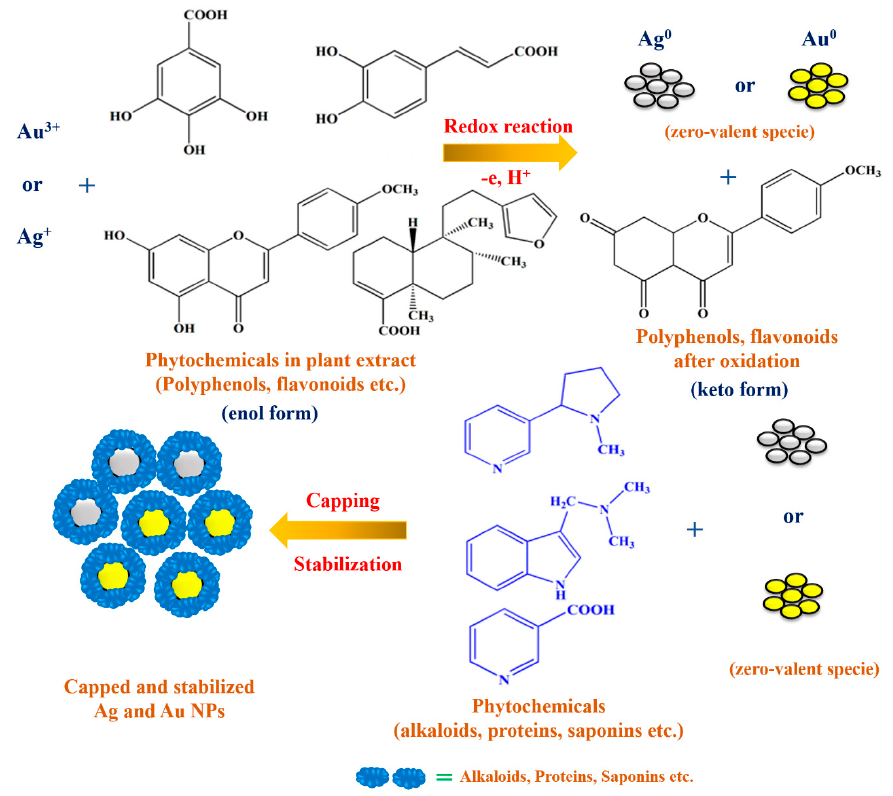
Figure 15. The schematic illustration displays the anticipated mechanism for green synthesis of CI-Au NPs and CI-Ag NPs using leaves extract of C. inerme .